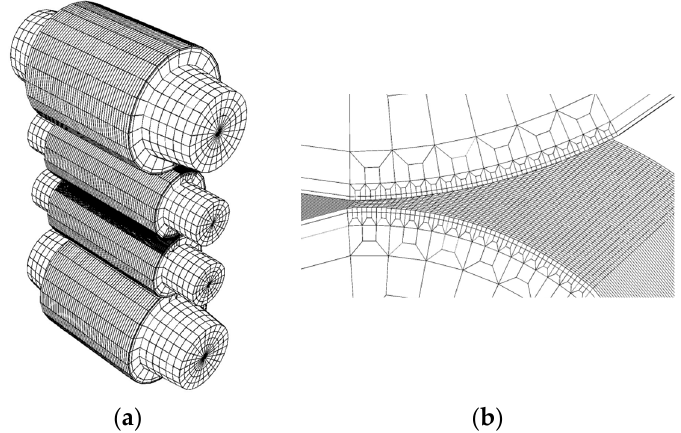
Figure 4. ( a ) Finite element simulation model; ( b ) zone of contact.